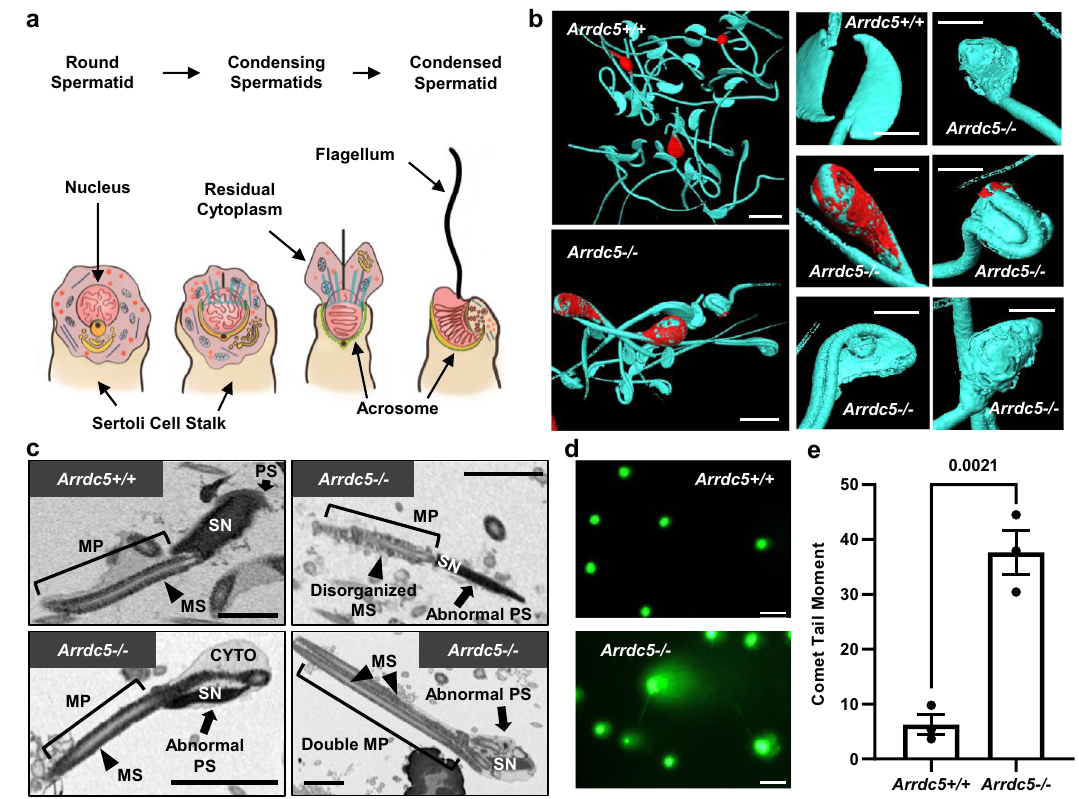
Fig. 6 | Assessment of spermiogenesis in Arrdc5 − / − mice. a Schematic depicting the major steps in spermiogenesis that occur in the seminiferous epithelium of mouse testes. b Three-dimensional scanning electron microscopy for epididymal sperm of adult Arrdc5 + /+ and Arrdc5 − / − littermates. A variety of sperm head, neck, midpiece, and tail defects were observed for sperm of Arrdc5 − / − mice, including retained cytoplasm as indicated by red coloring. Bars are 5 μ m. c Transmission electron microscopy for epididymal sperm of adult Arrdc5 + /+ and Arrdc5 − / − lit- termates.Defectsinthe spermnucleus(SN),postacrosomalsegment (PS,arrows), and mitochondrial sheath (MS, arrowheads) of the midpiece (MP, brackets) were observed for sperm of Arrdc5 − / − mice compared to sperm from Arrdc5 +